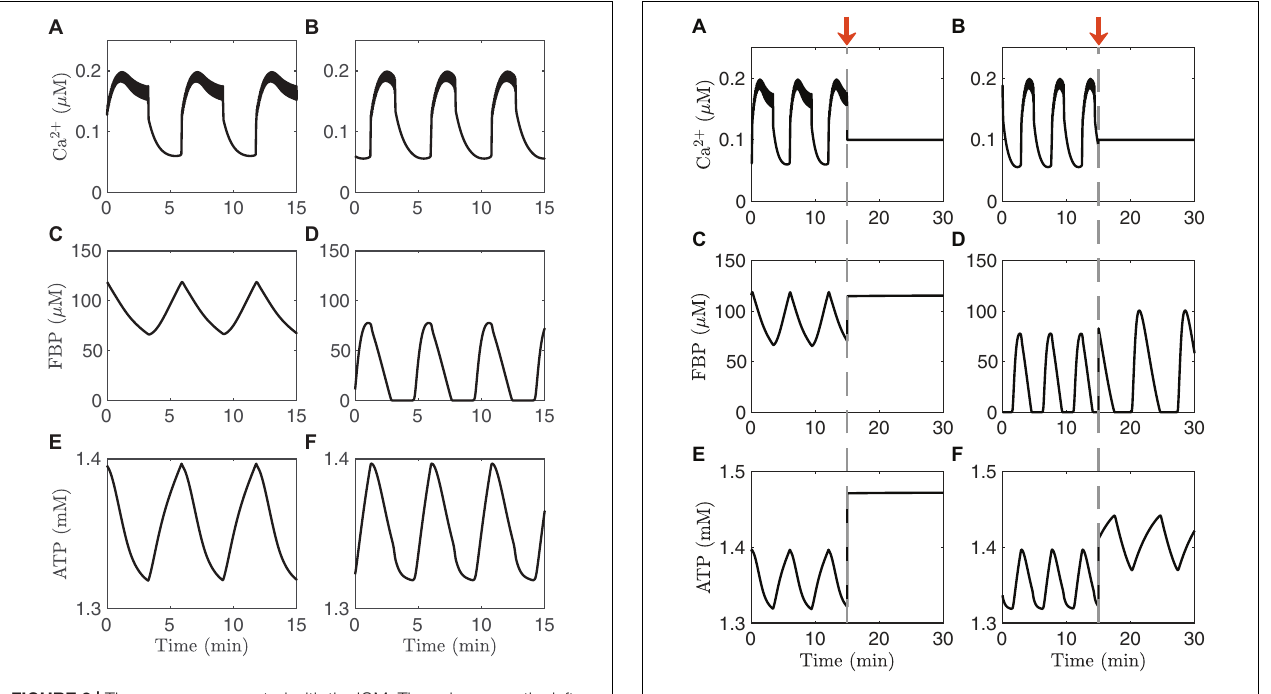
FIGURE 4 | Time courses generated with the IOM. The columns on the left (A,C,E) show an example of PMOs, while those on the right (B,D,F) show an example of AMOs. At time t = 15 min (arrow), the Ca 2 + concentration is clamped. In the model with the PMOs (left column) all oscillations stop, while in case of AMOs (right column) the metabolic oscillations persist. The values of v PDH and g K ( Ca ) and glucose are the same as in Figure 3